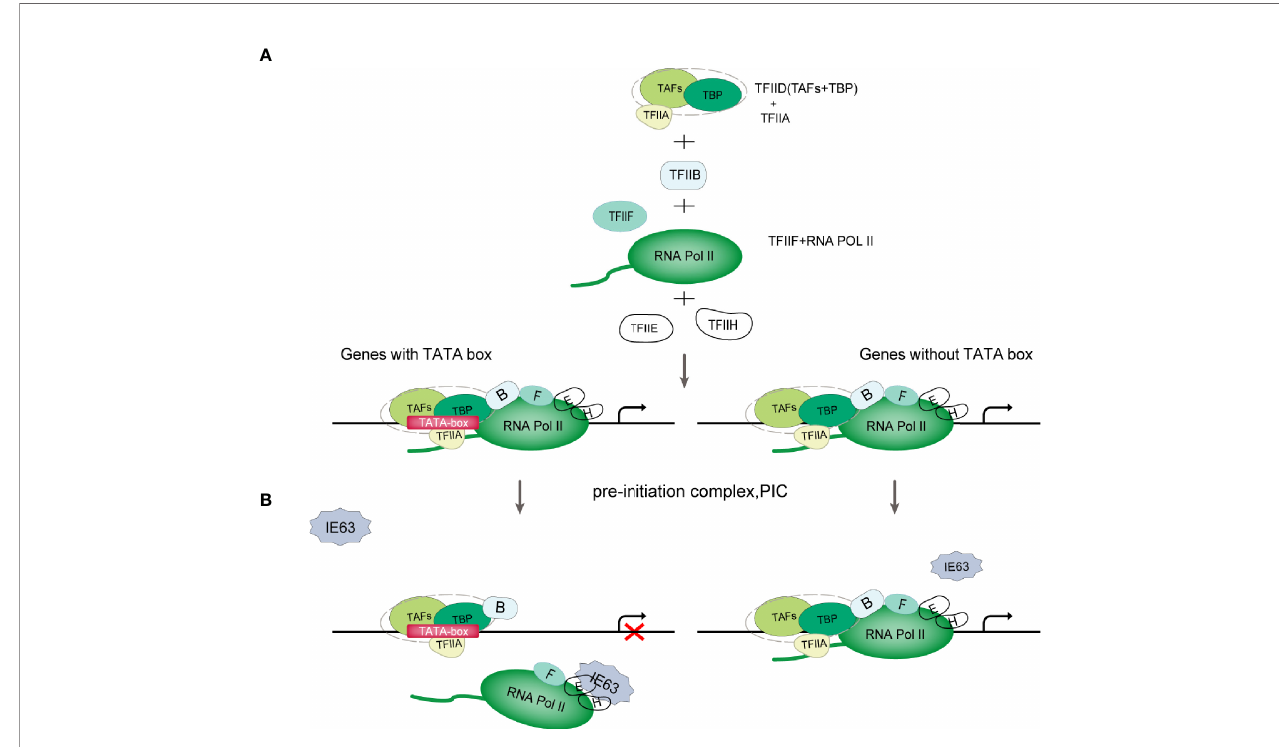
FIGURE 2 | Schematic diagram of VZV IE63 hindering PIC assembly. (A) PIC assembly. The TFIID subunit TBP recognizes and binds to the TATA-box element on the promoter; then TFIIB binds to TBP, and TFIIB can also bind to DNA; then the TFIIB-TBP complex binds to the Pol II-TFIIF complex, and TFIIF can pass through Pol II interacts with TFIIB to reduce the binding of Pol II to the nonspeci fi c part of DNA, thereby assisting Pol II to target binding to the promoter; fi nally, with the participation of TFIIE and TFIIH, PIC assembly is completed (31). (B) Schematic diagram of VZV IE63 affecting the assembly of the PIC. For genes containing a TATA box on the promoter, the ectopic expression of IE63 can interact with TFIIH, TFIIE and Pol II in the PIC on the promoter, creating steric obstacles to the assembly of the PIC, thereby interfering with the stability of the transcription initiation complex and inhibiting the initiation of transcription. In contrast, IE63 has no effect on genes without a TATA